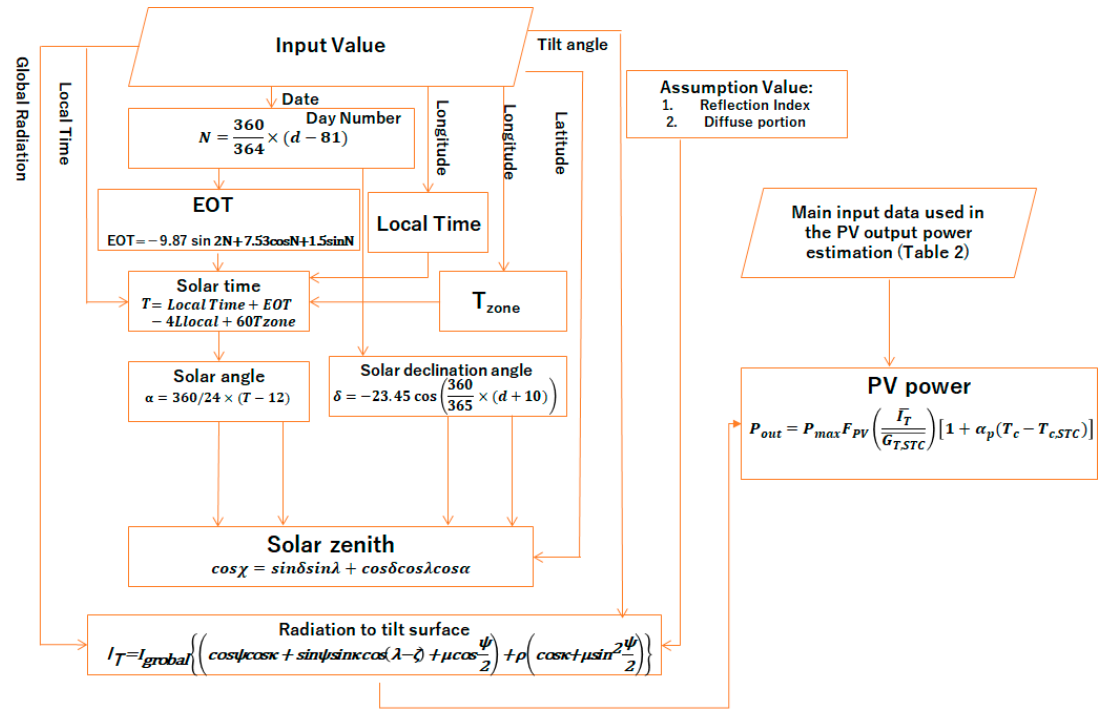
Figure 3. Calculation flow in solar power simulation.